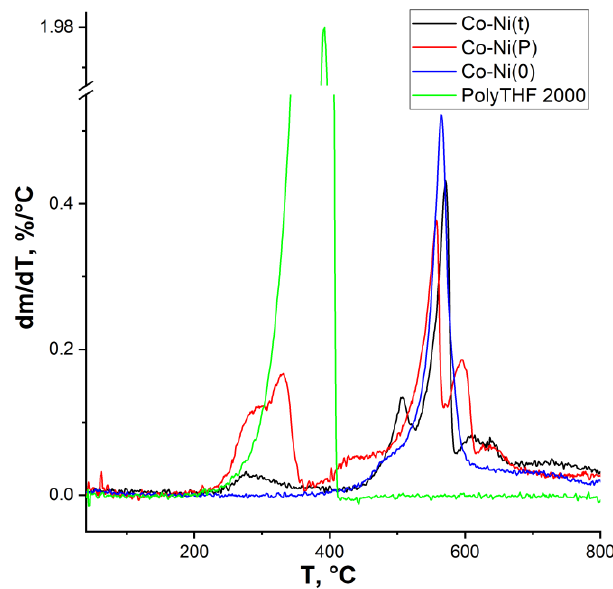
Figure 2. Derivative thermogravimetry (DTG) curves for the Co-Ni complexes used in this work and for poly(THF).